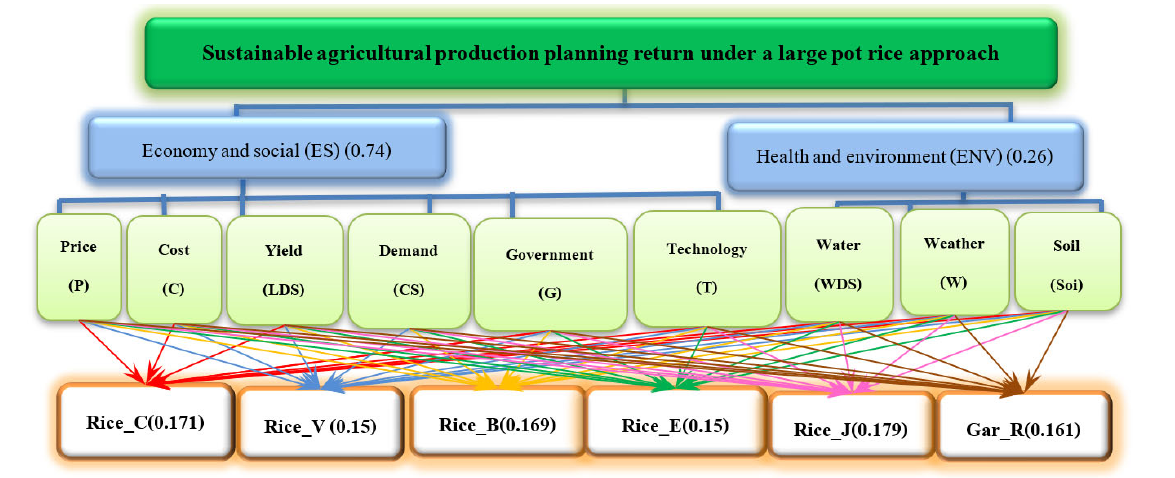
Fig. 1 . Hierarchical analysis to sustainable agricultural production planning